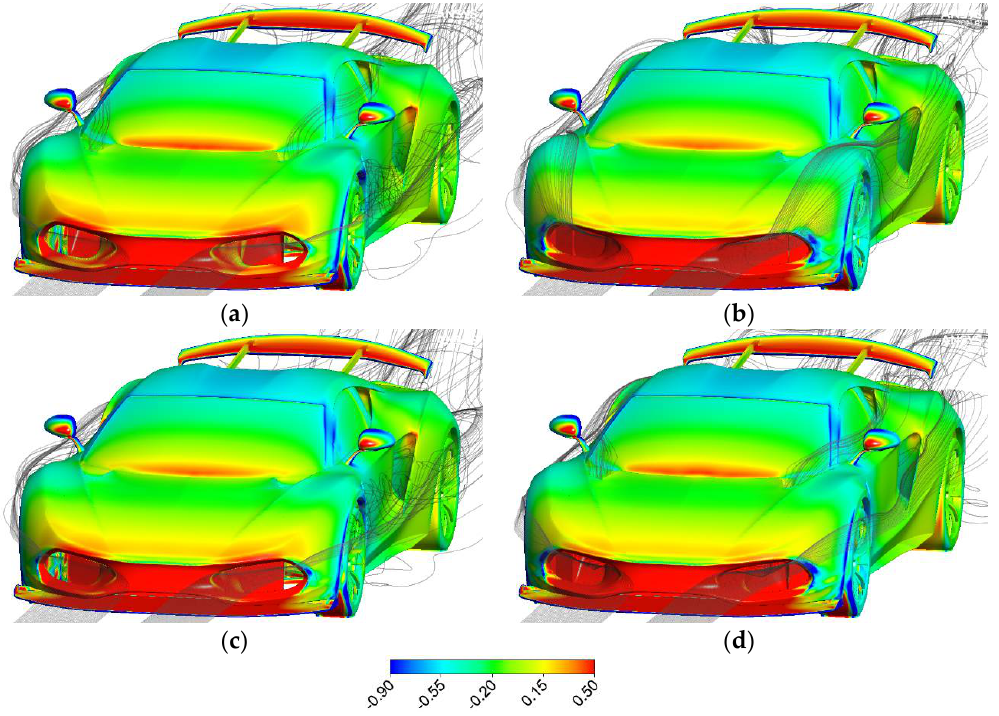
Figure 10. Contours of the pressure coefficient on the car’s body with superimposed pathlines: ( a ) Both inlets opened, ( b ) both inlets closed, ( c ) inward inlet blocked, ( d ) outward inlet blocked. Table 4. Aerodynamic coefficients for different air intakes configurations.